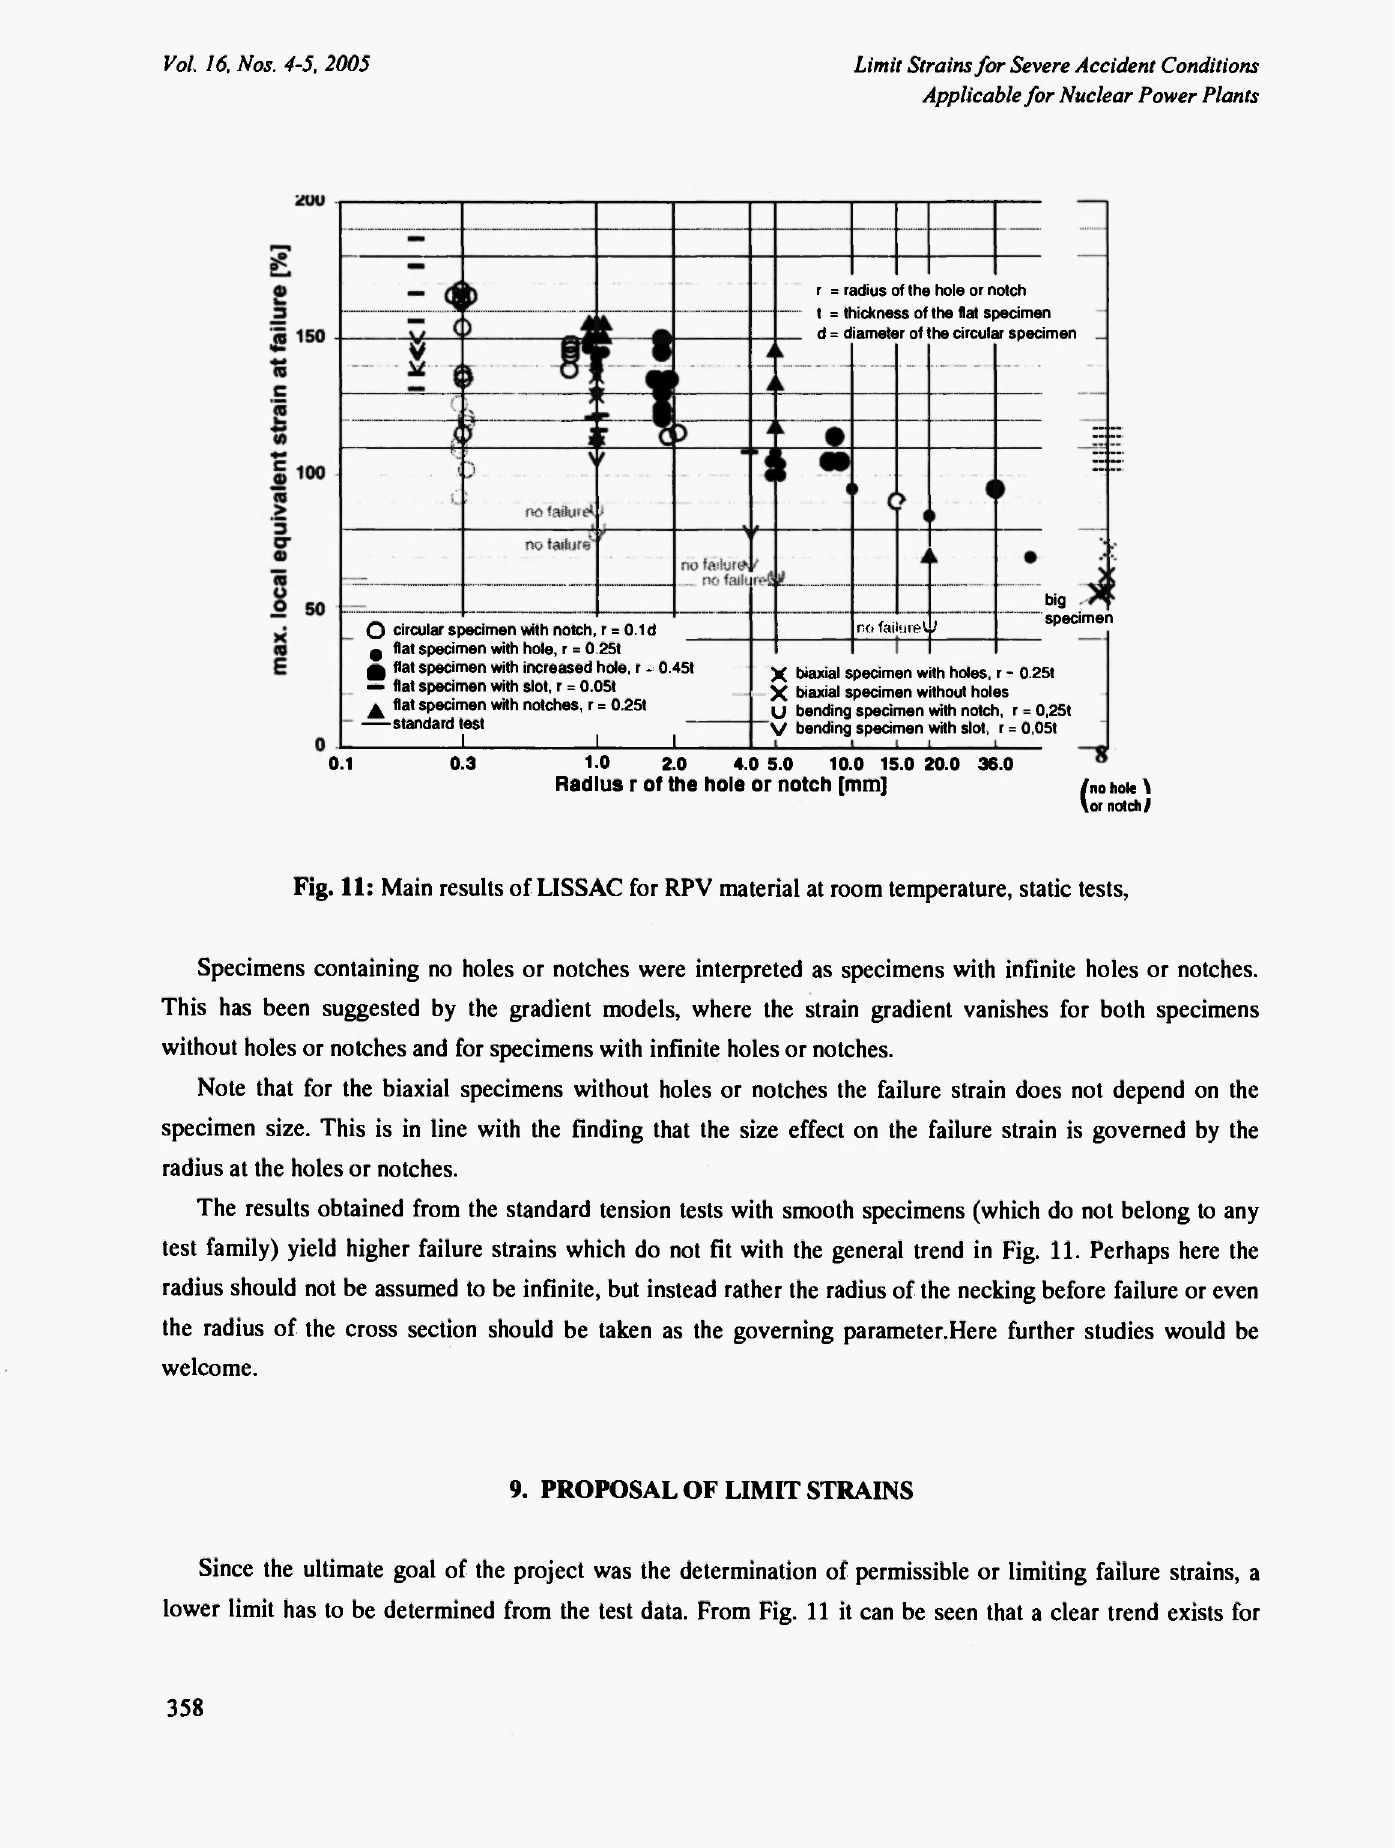
Fig. 11: Main results of LISSAC for RPV material at room temperature, static tests,